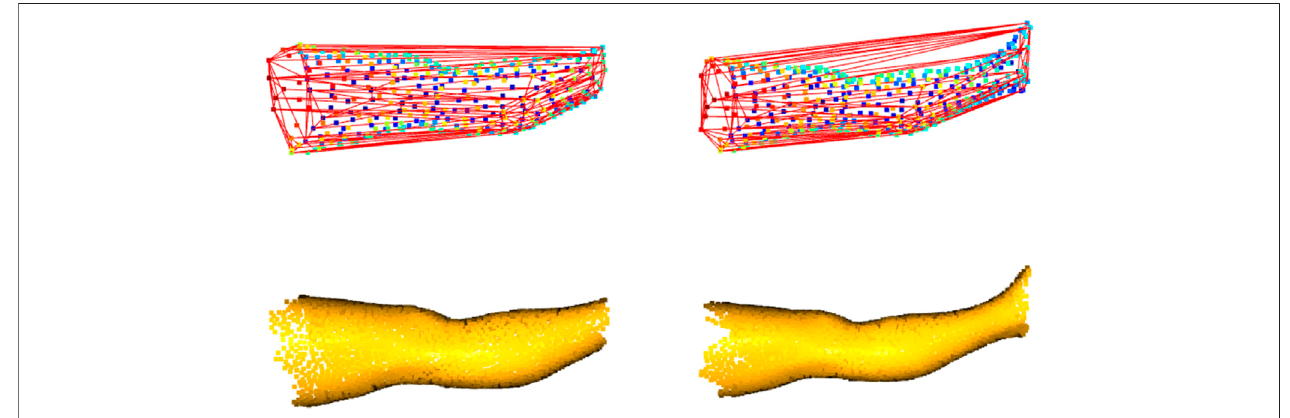
FIGURE 3 | Convex-hull of two leg portions: shape enclosing the boundary points shows distortions, mainly when the limb includes the ankle (on the